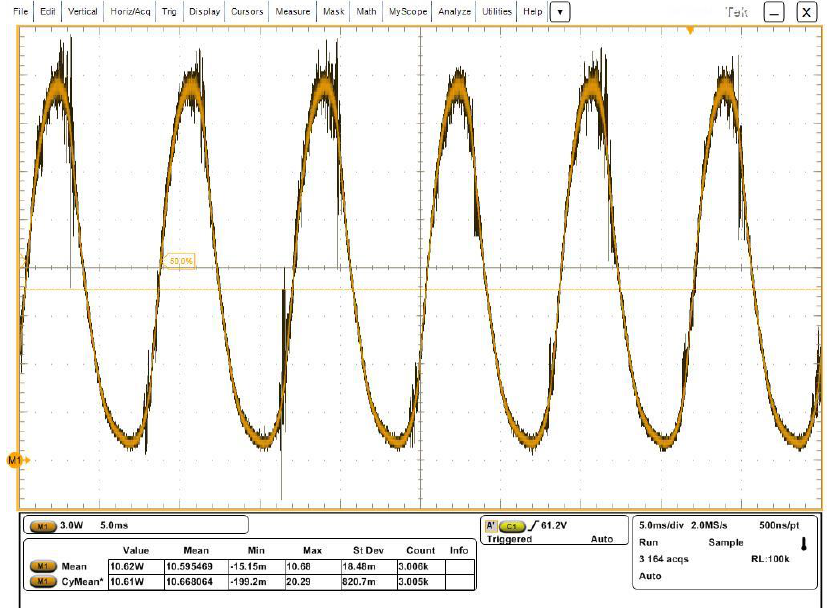
Figure 20. Instantaneous power in experimental tests of the LED lamp. 3 W/div, average power in the LED 10.62 W.